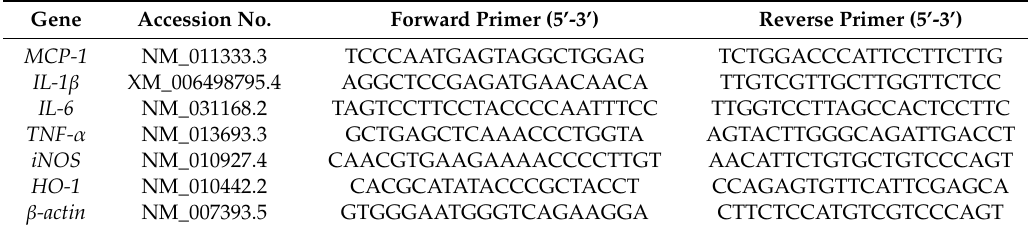
Table 1. Sequences of primers used for